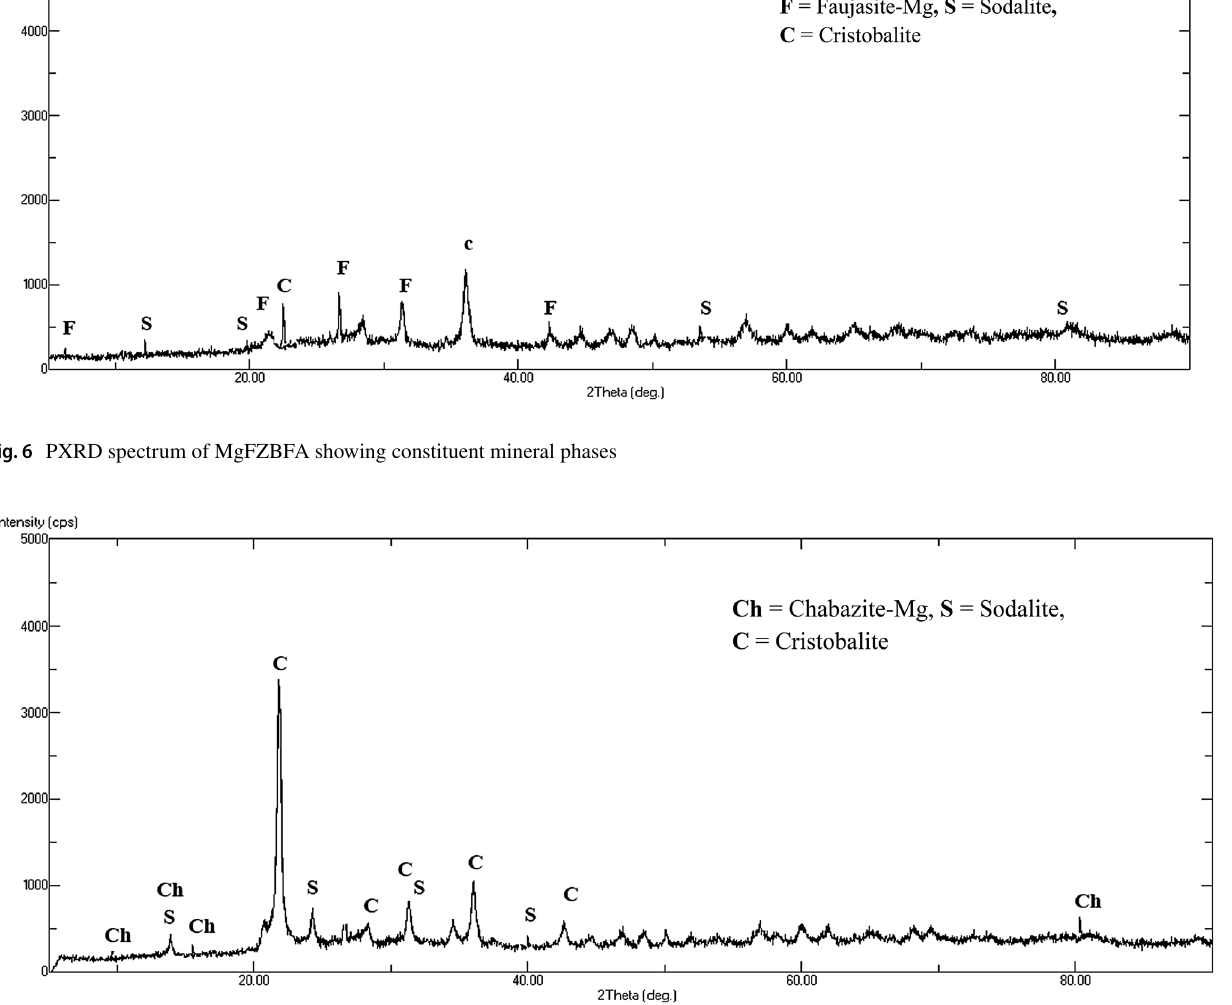
Fig. 7 PXRD spectrum of MgMZBFA showing constituent mineral